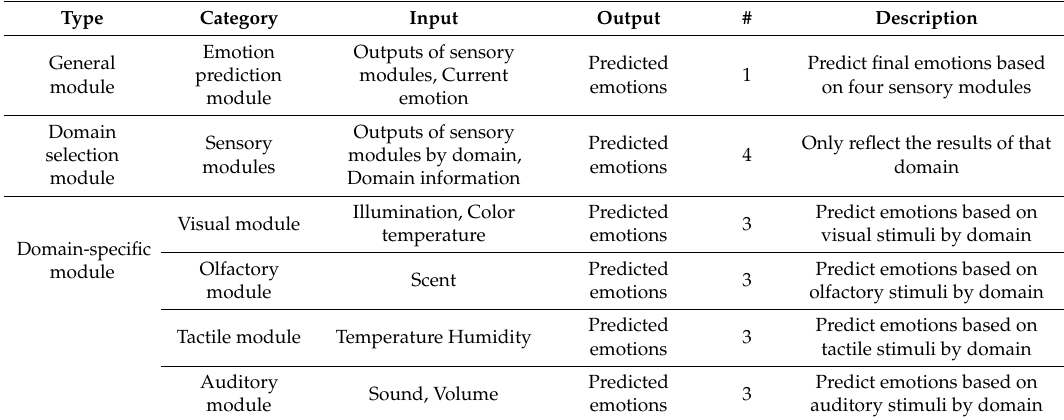
Table 8. Modules of emotion prediction model.